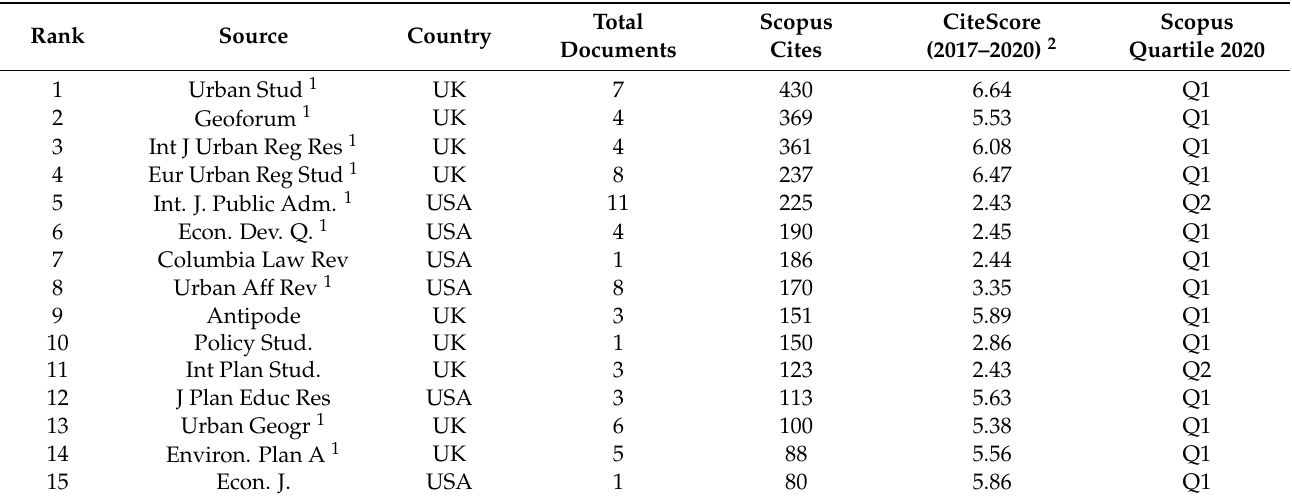
Table 4. Most prominent sources publishing on BIDs,